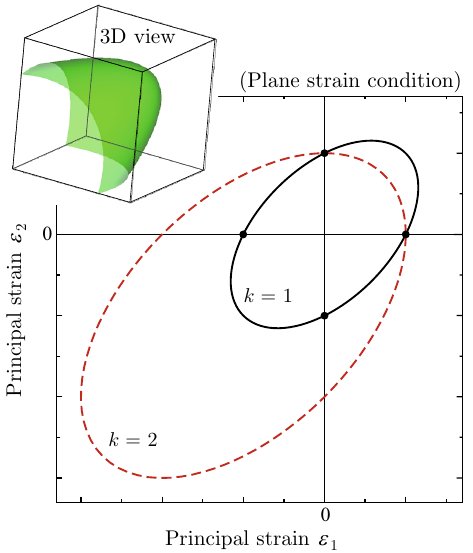
Fig. 3 Contour plot of modified von-Mises criterion The abovementioned formulation results in the damage model of two-phase